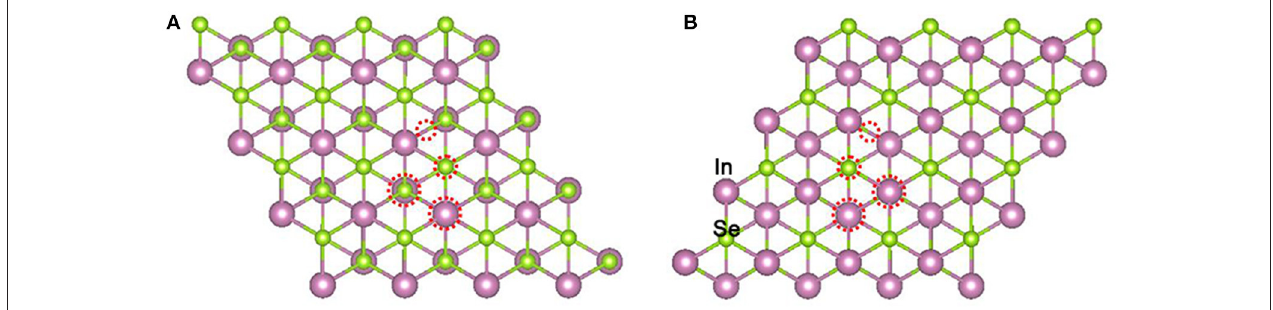
FIGURE 1 | Top views of typical adsorbing sites on the Se atom planes of one side (A) and the other side (B) of the α -In 2 Se 3 monolayer. The adsorbing sites are denoted by red dotted